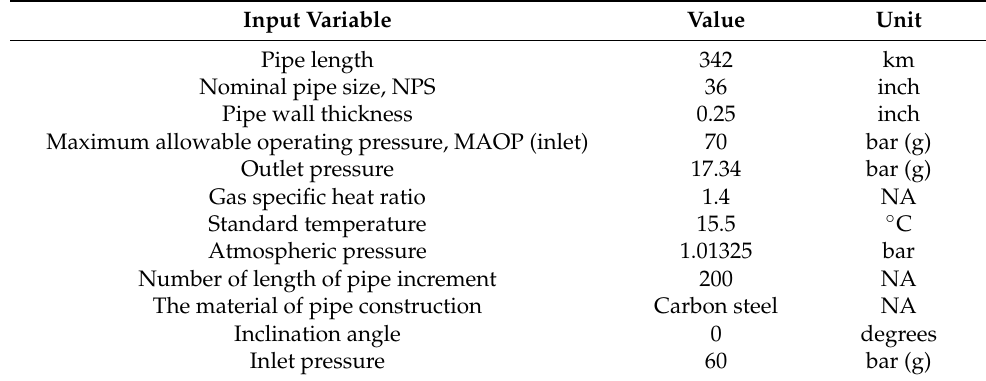
Figure 5. Free ‐ flow pipeline model. Figure 5. Free-flow pipeline model. Table 3. Additional model parameters for high ‐ pressure flow of hydrogen in natural gas pipelines. Table 3. Additional model parameters for high-pressure flow of hydrogen in natural gas